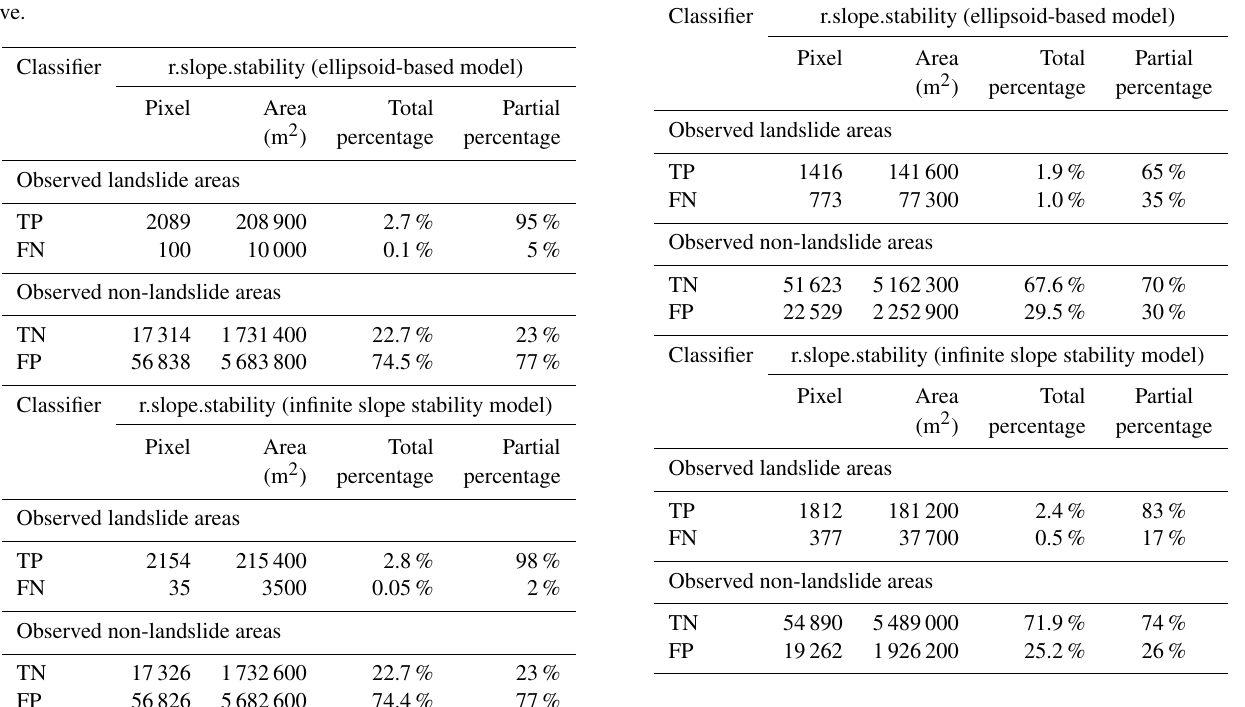
Table 3. The confusion matrix for the probabilistic